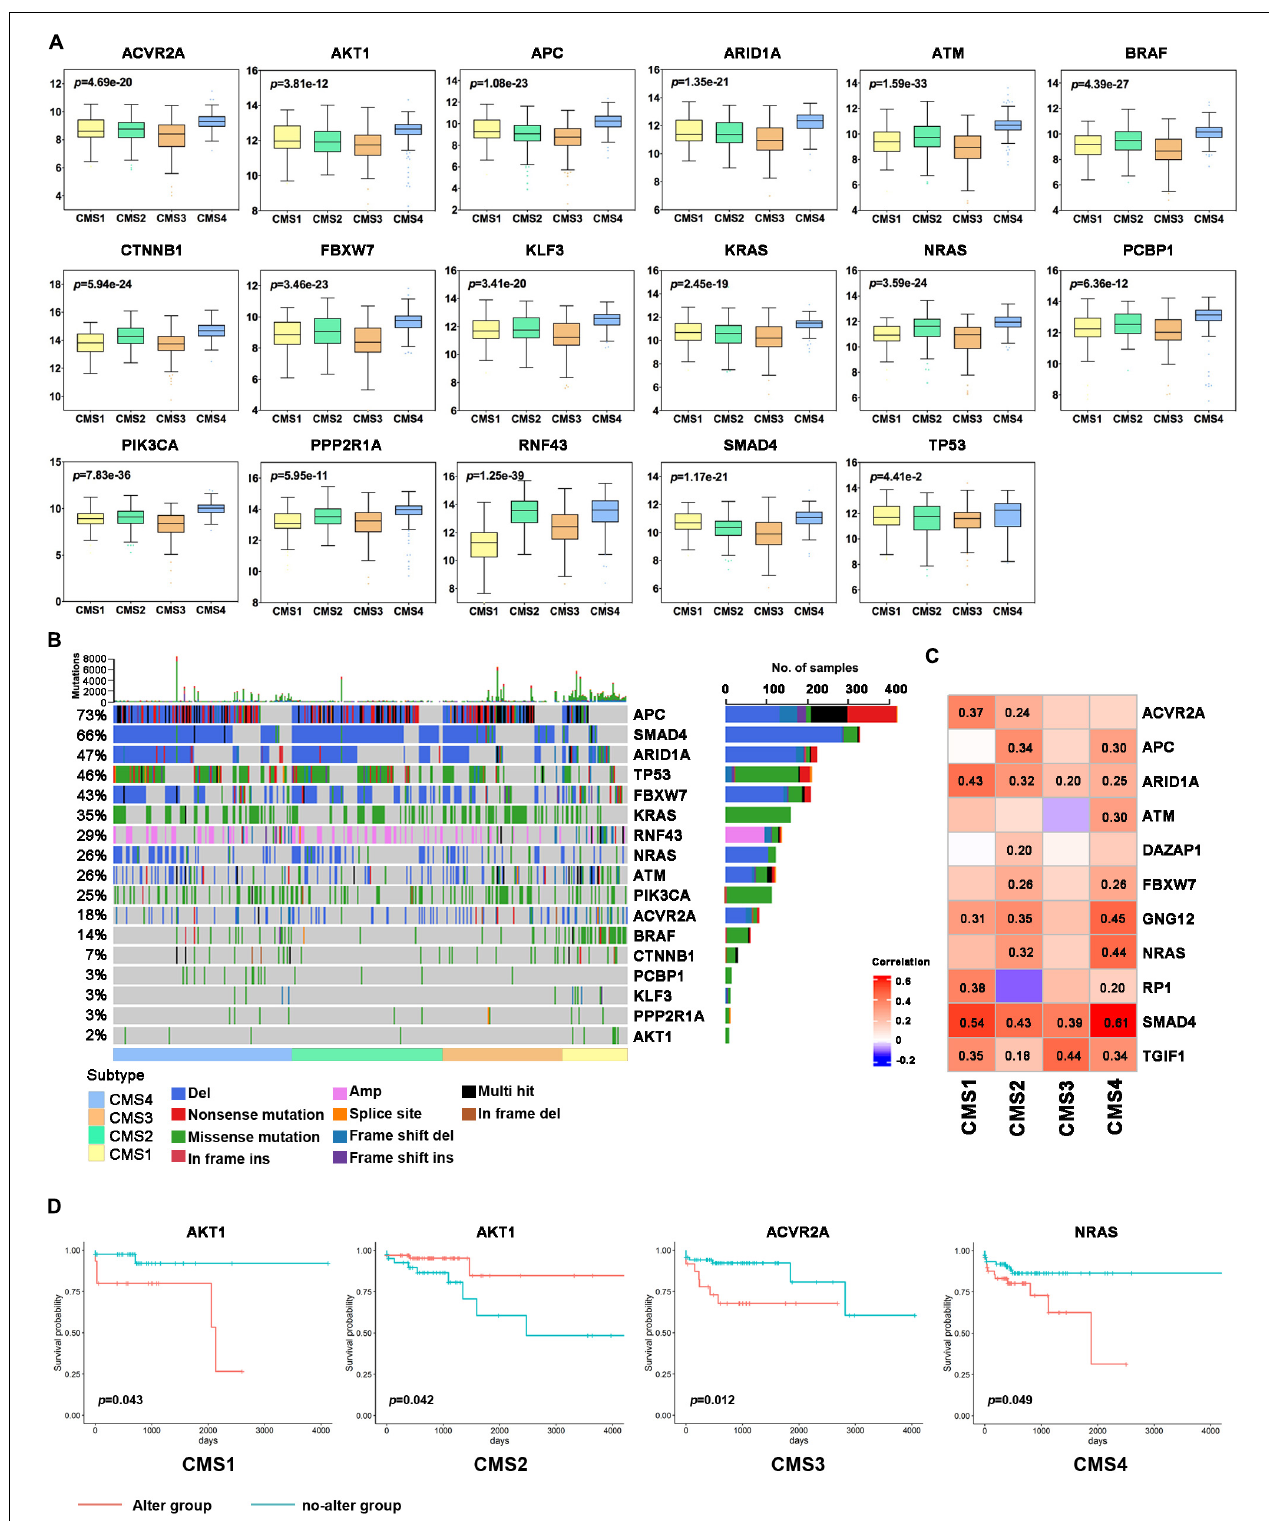
FIGURE 4 | Analysis of driver genes in the different colon cancer subtypes. (A) Expression levels of the driver genes in each subtype. (B) Waterfall chart of the frequency of mutations in the driver genes in each subtype. (C) Correlation analysis of subtype-specific RNAs and their modifications in the different subtypes. (D) Kaplan–Meier survival curve of the driver genes with gene mutations. Red indicates the gene alteration group, and blue indicates the no-alteration group.